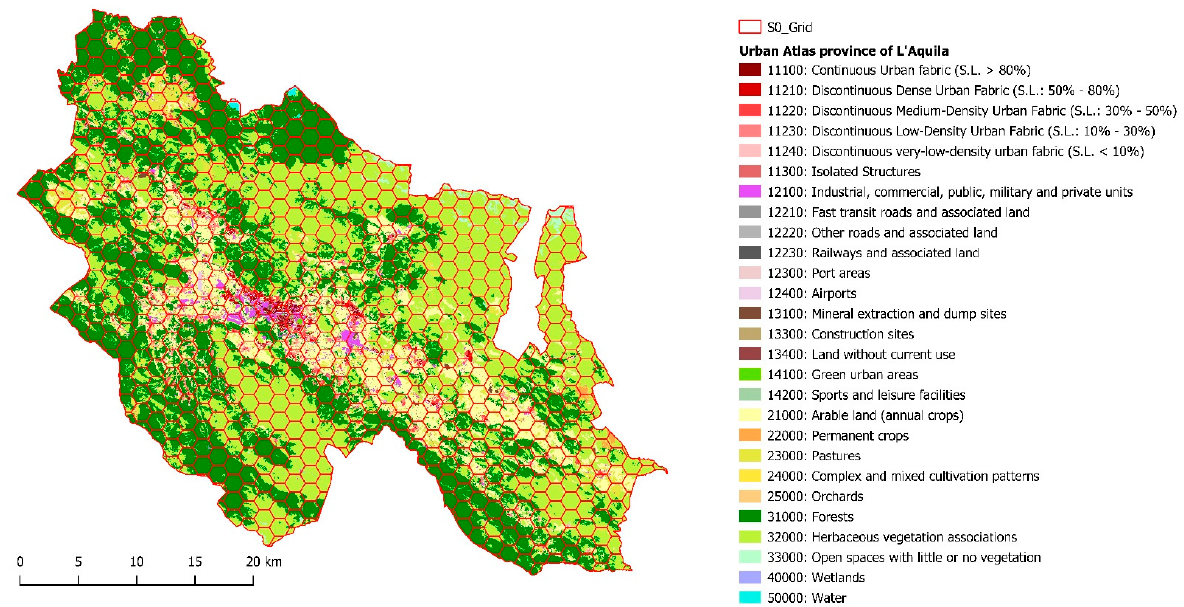
Figure 4. First grid intersection (S 0 —Null shift) with the Urban Atlas dataset.